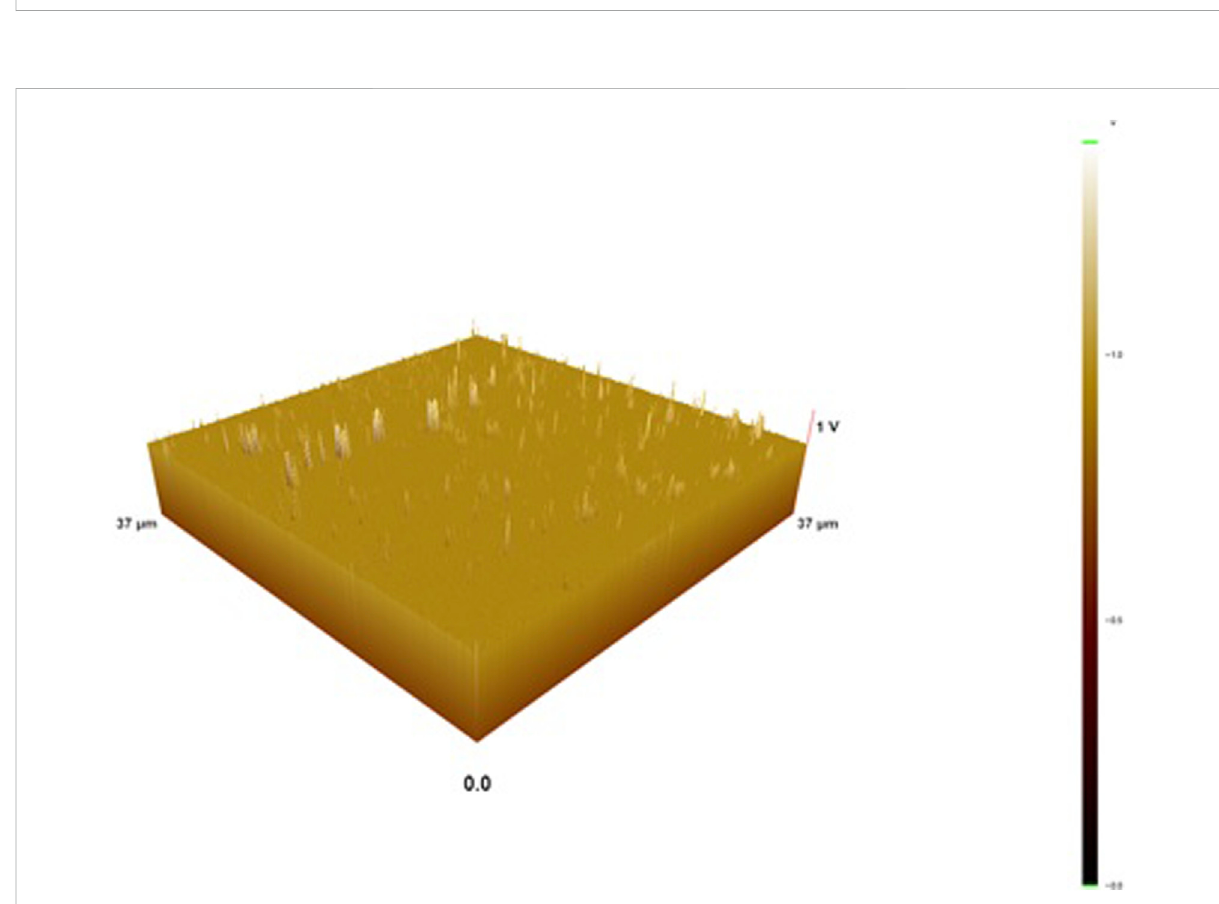
FIGURE 5 AFM image of Ag nanoparticles obtained by green synthesis via